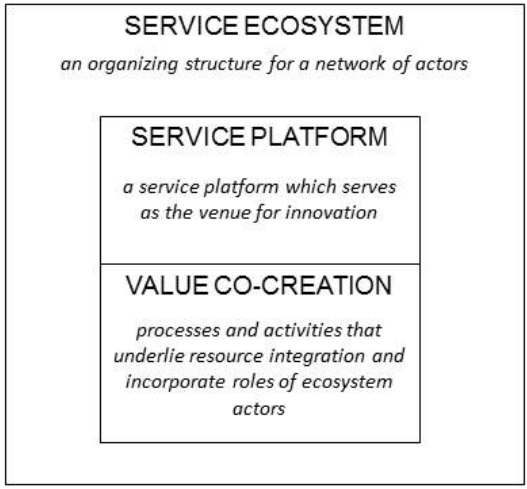
Fig. 2. A simplified version of service innovation framework. Source: Adaptation of Figure 1 from Lusch and Nambisan (2015, p. 162). Copyright © 2015, Regents of the University of Minnesota. Reprinted by